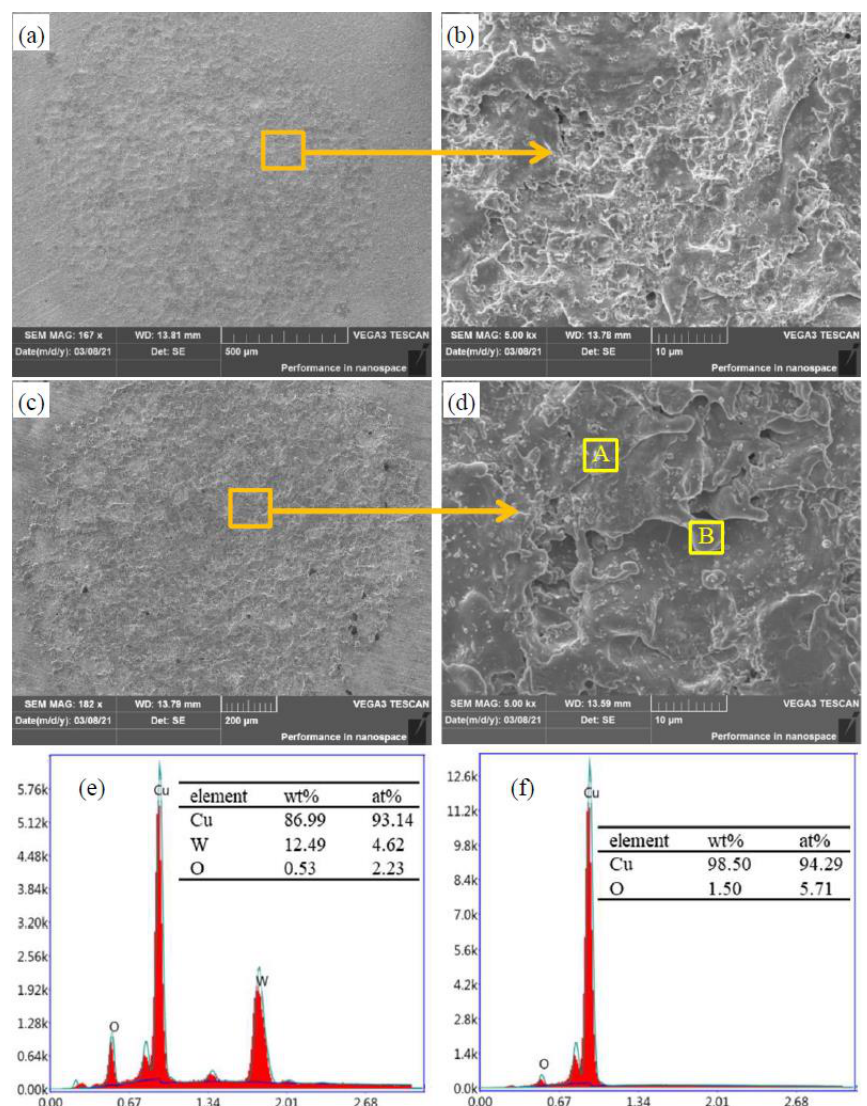
Figure 13. Surface observation and analysis of Cu-10 wt% W composite contacts after electrical contact test: ( a ) anode contact; ( b ) enlarged view of ( a ); ( c ) cathode contact; ( d ) enlarged view of ( c ); ( e ) EDS of area A in ( d ); ( f ) EDS of area B in ( d ).